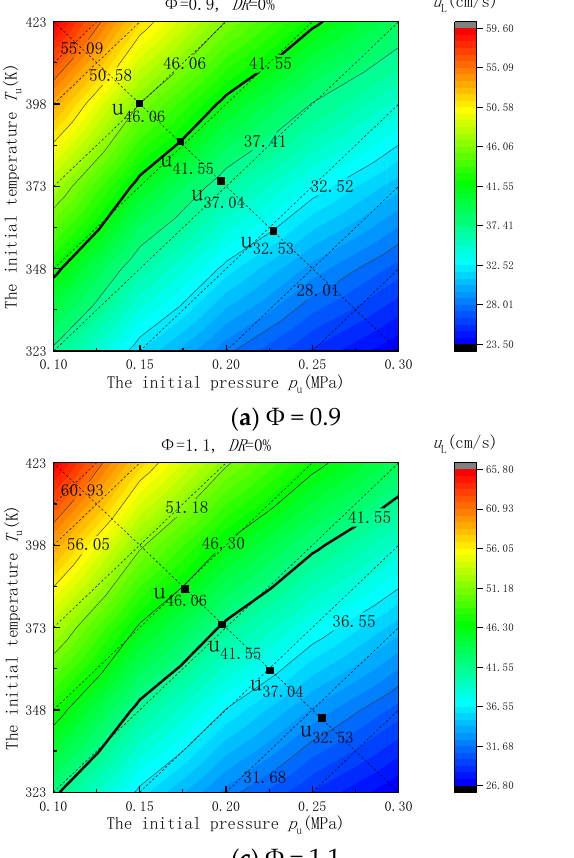
L corresponding to the initial condition change with